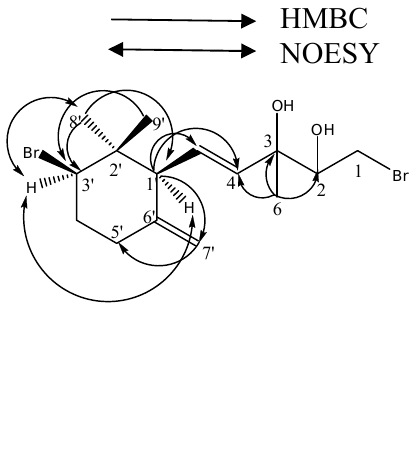
Figure 2. Selected HMBC and NOESY correlations of compound 1